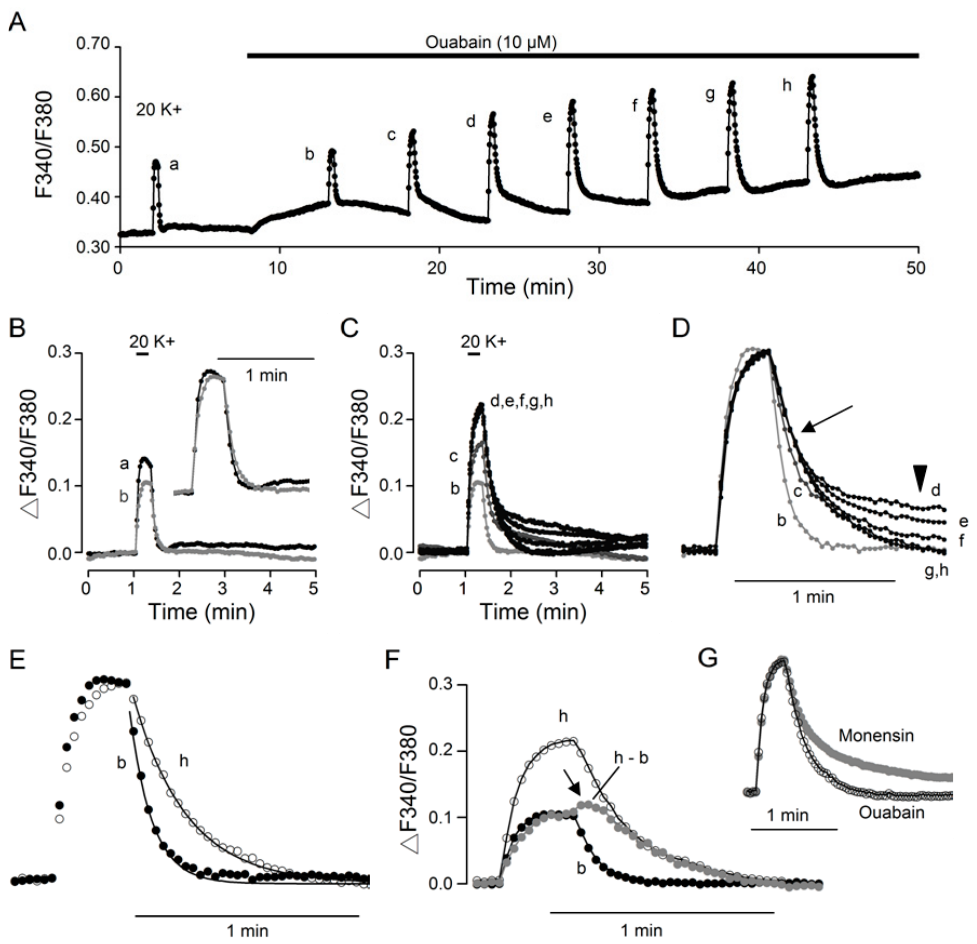
Figure 4. Ouabain effects on the 20 K + -evoked Ca 2+ transient. ( A ) A representative experiment showing the effect of 10 µM ouabain on the averaged Ca 2+ response ( n = 13 cells) to 20 mM K + . Note the initial inhibition of the Ca 2+ transient at 5 min into ouabain. ( B ) Superimposition of Ca 2+ transients evoked before (a, dark trace) and at 5 min in ouabain (b, grey trace). Inset shows the normalized Ca 2+ transients to indicate a slightly slower kinetics of Ca 2+ transient in ouabain. ( C ) Superimposition of Ca 2+ transients in the presence of ouabain to indicate ouabain-induced enhancement of the amplitude and slowing of the kinetics of the Ca 2+ transient. Note the nearly identical amplitude and rising and rapid falling phases of the Ca 2+ transients between 15 and 35 min into ouabain, indicating a steady state being reached after 15 min of ouabain application. ( D ) Normalized Ca 2+ transients (from C ) to indicate the ouabain-induced gradual slowing of the fast Ca 2+ decay at 5 (b), 10 (c), and 15–35 min (d–h). Note the virtually identical fast Ca 2+ decay (marked by arrow) but varied slow decay phase (marked by arrowhead) (d–h). The slow Ca 2+ decay phase at 10 min (c) was truncated for better visualization. ( E ) Normalized Ca 2+ transients at 5 min (b, filled circle trace) and 35 min (h, open circle trace) into ouabain for curve fitting. The smooth curves through the data points were calculated with a fast time constant of 6 s and 14 s at 5 (b) and 35 (h) min, respectively. ( F ) Superimposition of Ca 2+ transients at 5 min (b, dark filled circle trace) and 35 min in ouabain (h, open circle trace), as well as the digitally subtracted ouabain-enhanced Ca 2+ transient (h – b, grey filled circle trace). Note the delayed onset of Ca 2+ clearance (marked by arrow). ( G ) Normalized Ca 2+ transients in ouabain (trace h) and monensin (from Figure 2) to compare their kinetics. Similar to monensin, ouabain also enhanced the slow Ca 2+ decay, as evidenced by superimposing the Ca 2+ transient in the absence (filled dark circles) and presence (open circles) of